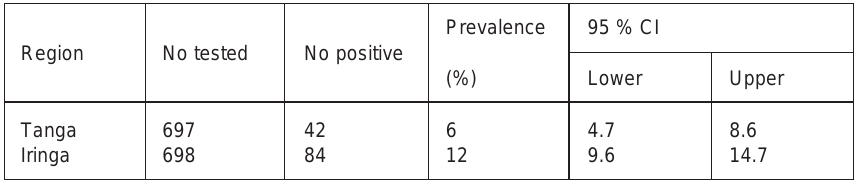
TABLE 2 The prevalence (with +/– 95 % confidence intervals) of cattle sero-positive for Babesia bovis in the study regions (January to April